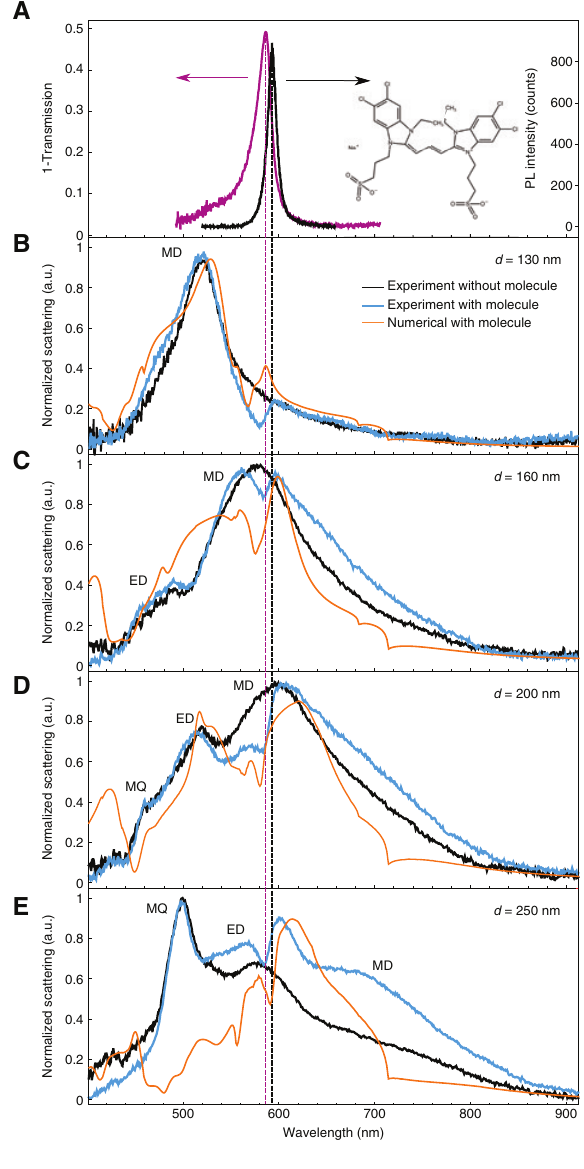
Figure 3: Resonance splitting in the scattering spectra. (A) Absorption (red) and photoluminescence (black) spectra of the J-aggregated dye (TDBC), the chemical structure of which is shown in the inset. (B–E) Evolution of the Mie-exciton coupling as a function of the nanodisk diameter. The black curves correspond to the nanodisk spectra without molecules, while the blue curves are the corresponding spectra in the presence of the dye. The orange spectra are numerically calculated for a silicon nanodisk with a thin (20 nm) dye layer on top (see Section